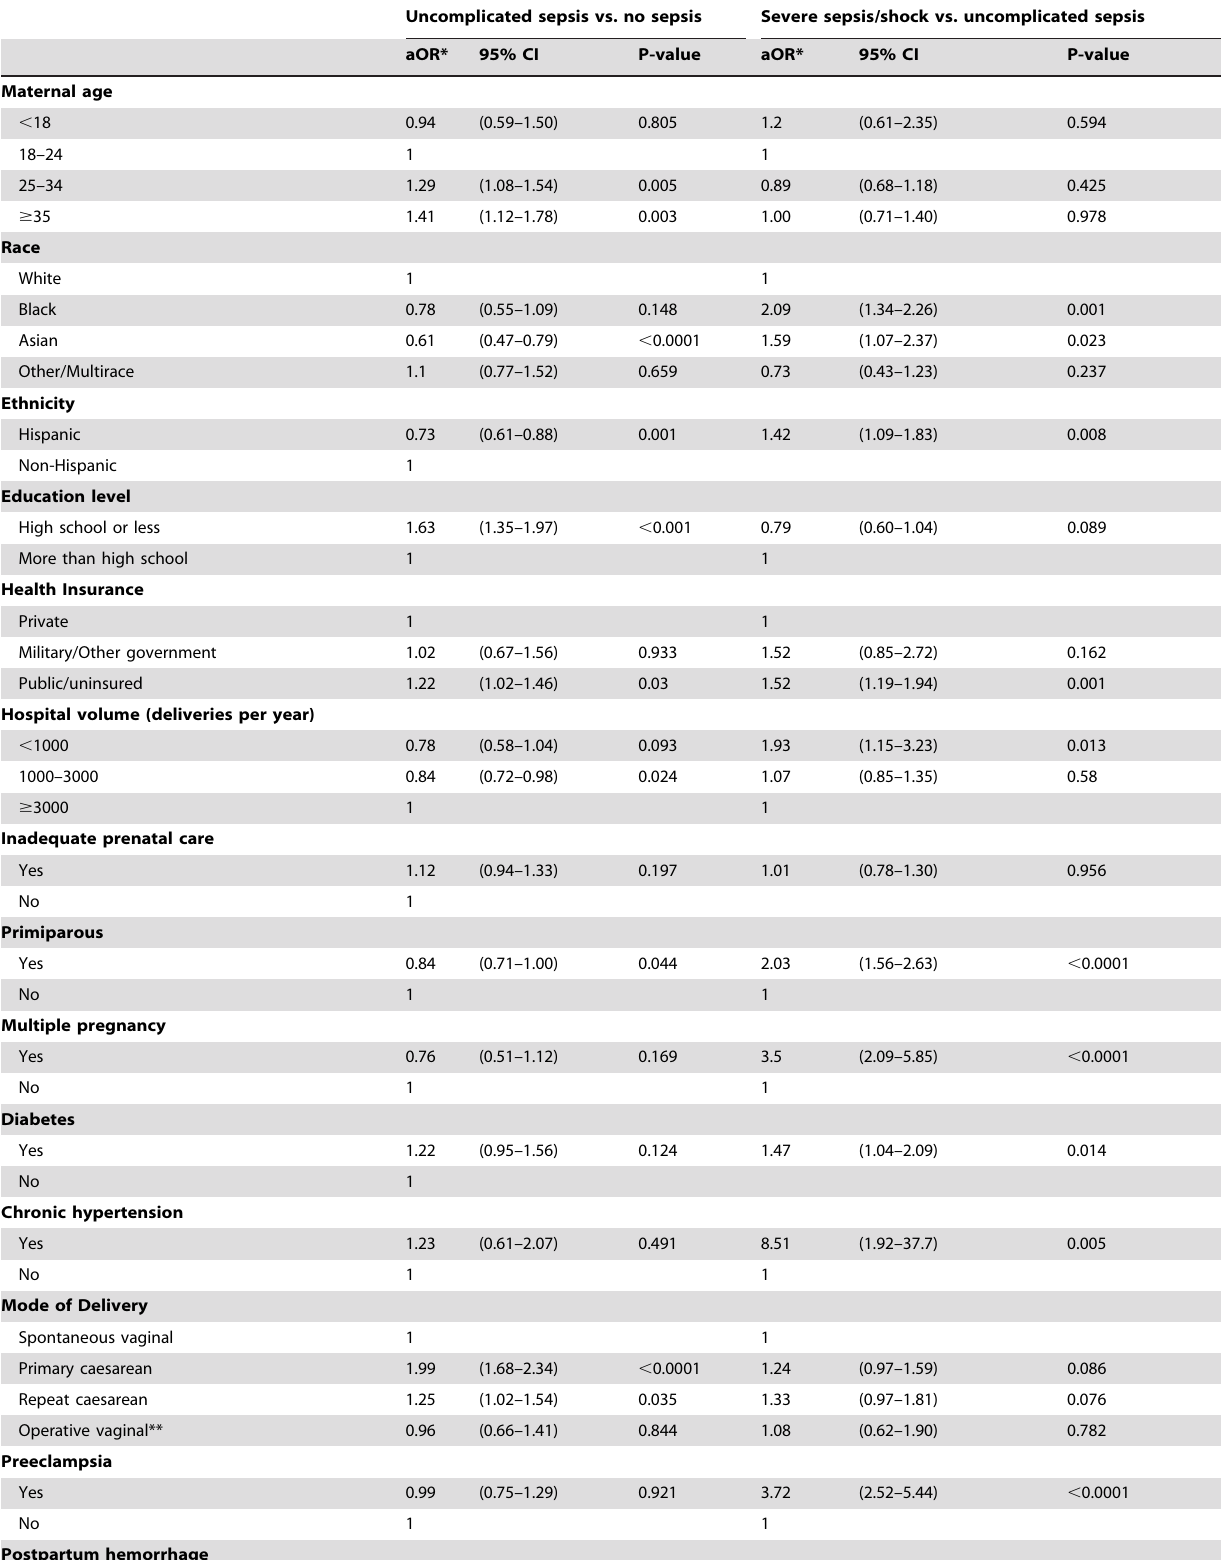
Table 4. Adjusted odds ratios for factors associated with uncomplicated sepsis and severe sepsis/septic